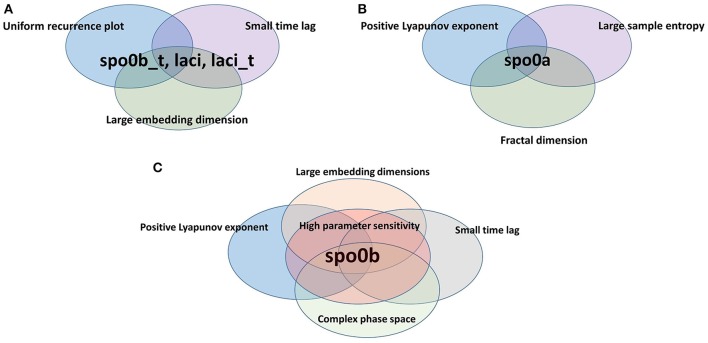
Species scoring positive to complexity indices. Species are organized according to the different sets of complexity indices they resulted to be positive to. (A)
spo0b_t, laci, and laci_t are characterized by uniformly irregular recurrence plot, a short time lag and an embedding dimension greater than the average. Indeed, they belong to the intersection of the set of species listed on rows 3, 4, and 7 of Table 2. (B)
spo0a has a maximal positive Lyapunov exponent, a large sample entropy and is fractional in dimension. Indeed, it belongs to the intersection of the sets of species listed on rows 1,2, and 5 of Table 2. (C)
spo0b has a maximal positive Lyapunov exponent, an embedding dimension greater than 1, a short time lag, and a high sensitivity to parameters. It belongs to the intersection of sets of species on rows 1, 3, 7, and 8 of Table 2.